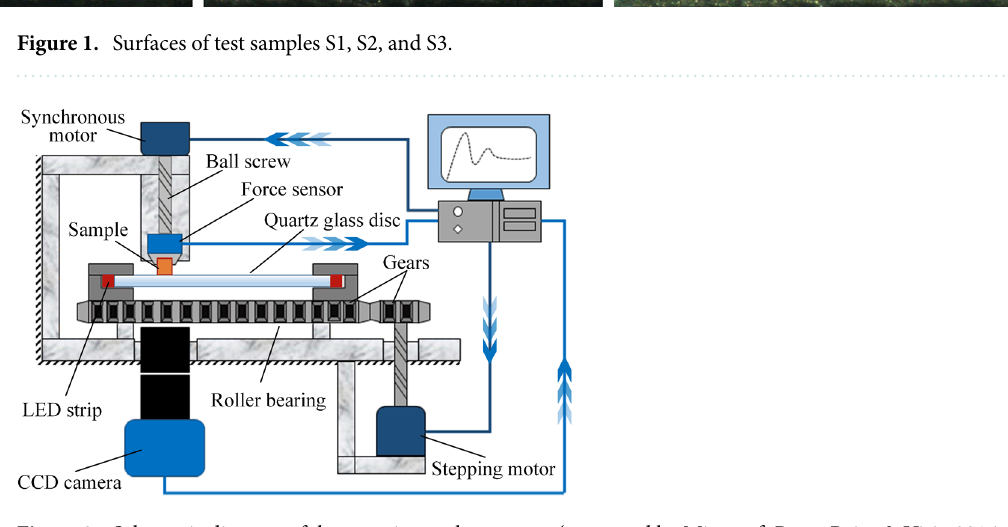
Figure 2. Schematic diagram of the experimental apparatus (generated by Microsoft PowerPoint & Visio 2016 MSO(16.0.4266.1001) 64 bits, http:// www. micro soft.